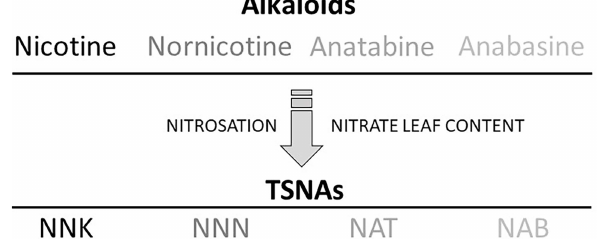
FIGURE 1 | Tobacco-specific nitrosamine (TSNA) formation in tobacco. Nitrosating agents essentially derived from nitrate storage pools react with the tobacco alkaloids nicotine, nornicotine, anatabine, and anabasine to generate the respective TSNAs, 4-(methylnitrosamino)-1-(3-pyridyl)-1- butanone (NNK), N '-nitrosonornicotine (NNN), N -nitrosoanatabine (NAT), and N -nitrosoanabasine